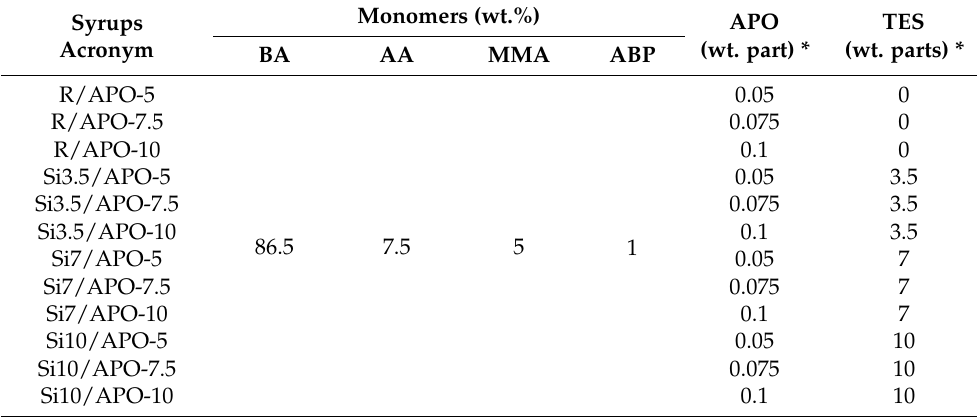
* per 100 wt. parts of monomer